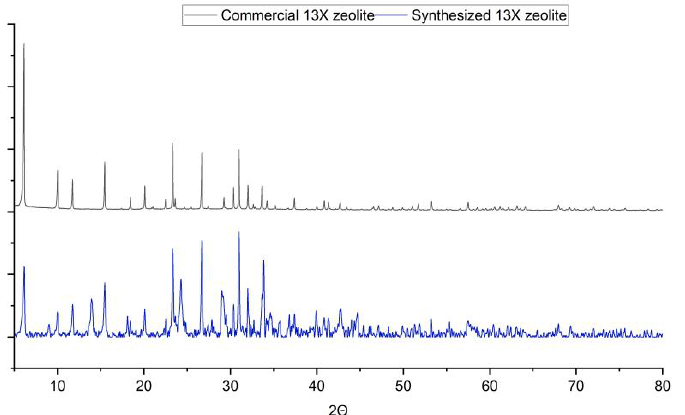
Figure 5. Phase Analisis Result Comparison: Commercial 13X Zeolite and Synthesized 13X Zeolite.